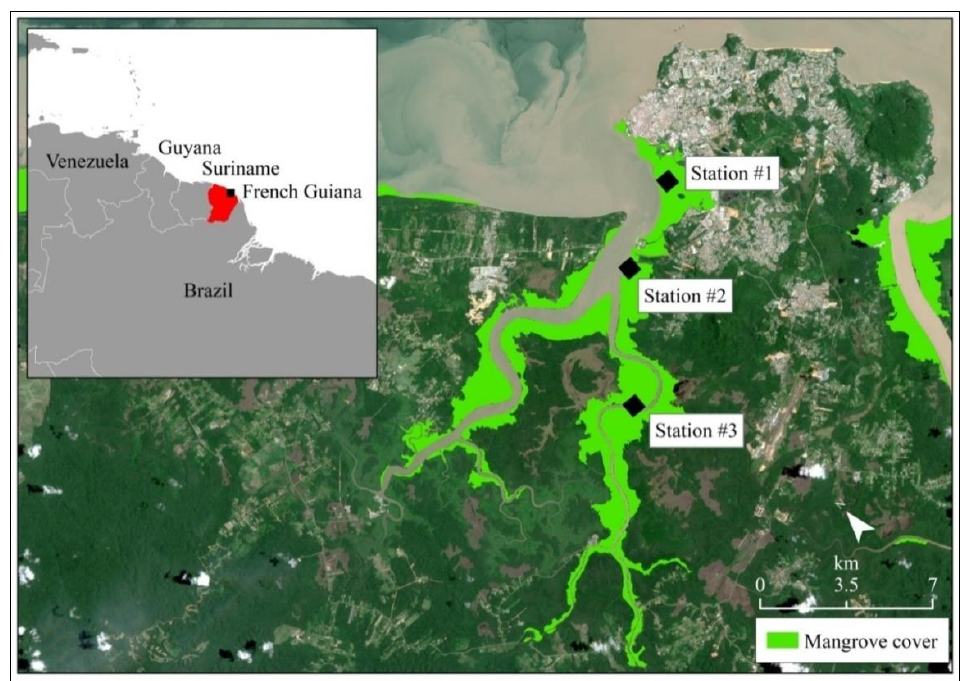
Figure 1. Study area and location of sampled stations. The study area was situated in the vicinity of the Cayenne estuary, in Atlantic Ocean, French Guiana (South America). The map in this Figure was generated by ArcGIS 10.5 software package (ESRI, Redlands, CA, USA, http://resources.arcgis. com/en/home/, accessed on 28 January 2021). The satellite image (Sentinel 2B acquired on 2 June 2018) was provided by the European Space Agency—ESA. The mangrove cover was mapped by photo-interpretation and manual